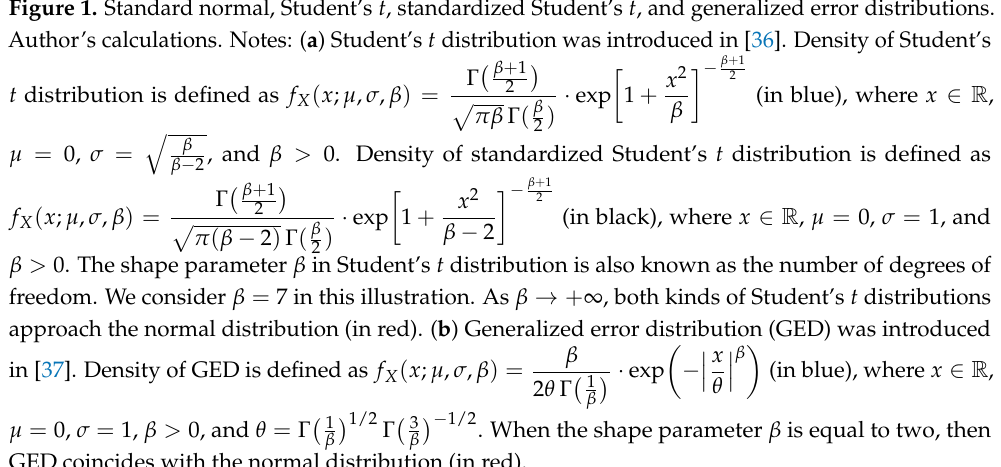
Figure 1. Standard normal, Student’s t , standardized Student’s t , and generalized error